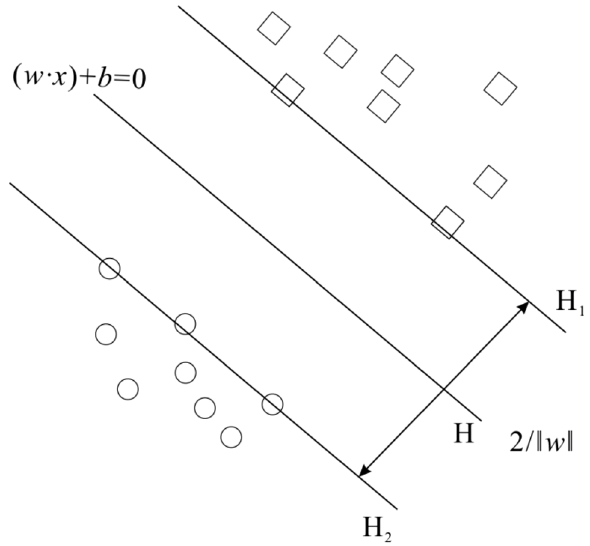
Figure 1. Schematic diagram of the optimal classification surface of two-type linear